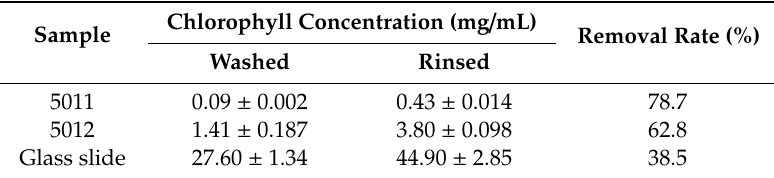
Table 5. Chlorophyll concentration on the